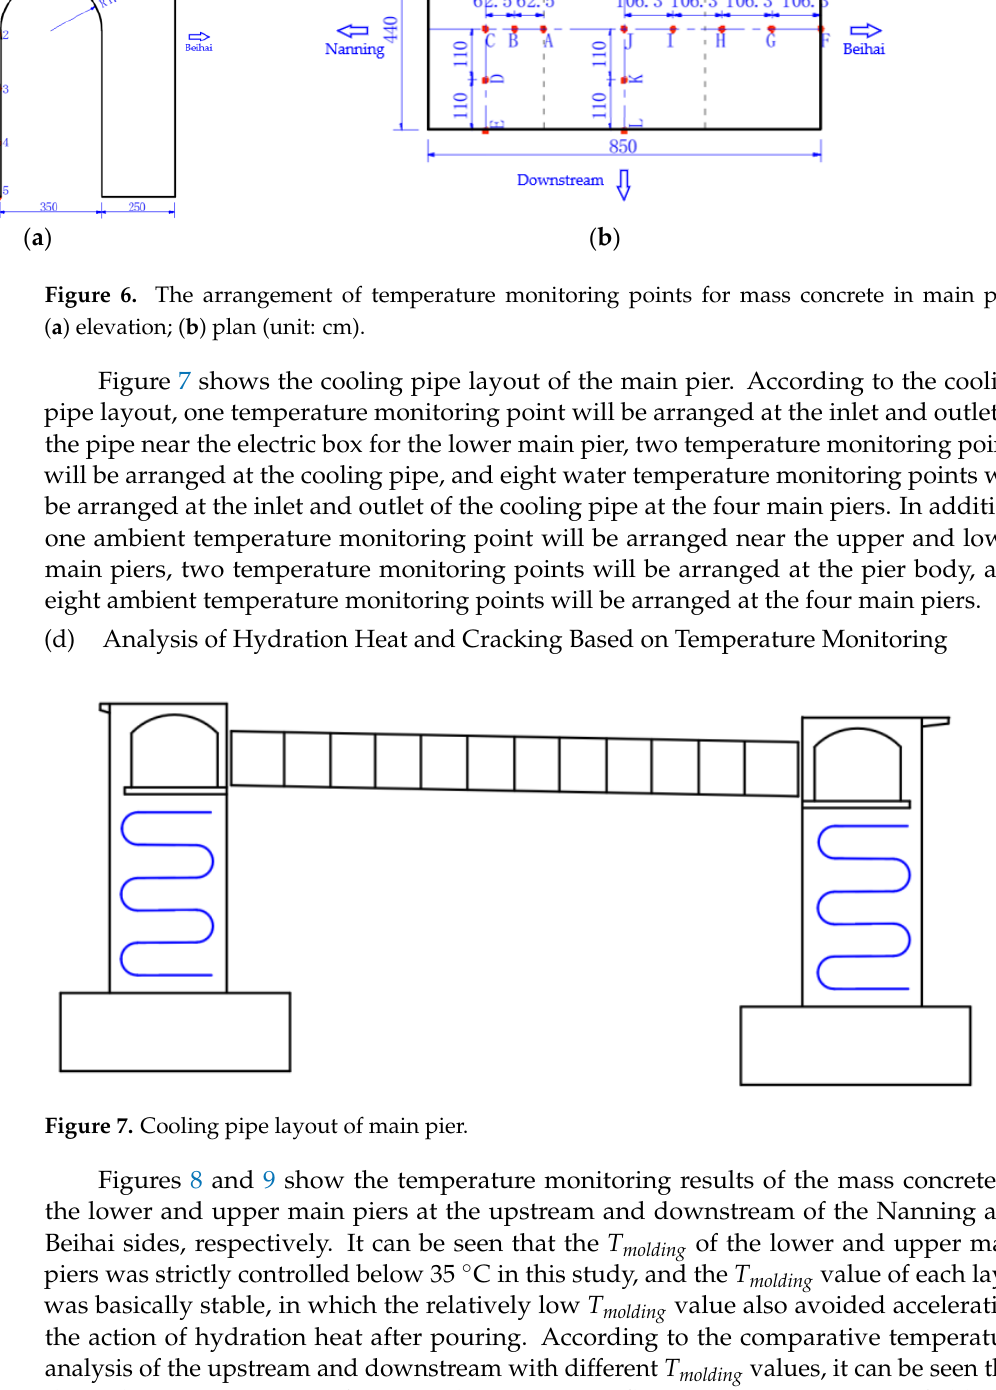
10 of 21 Figure 5. The temperature monitoring of mass concrete cushion cap: ( a ) at the upstream of Nanning side; ( b ) at the downstream of Nanning side; ( c ) at the upstream of Beihai side; ( d ) at the downstream of Beihai side. 3.1.2. Hydration Heat of Mass Concrete in Main Pier (c)